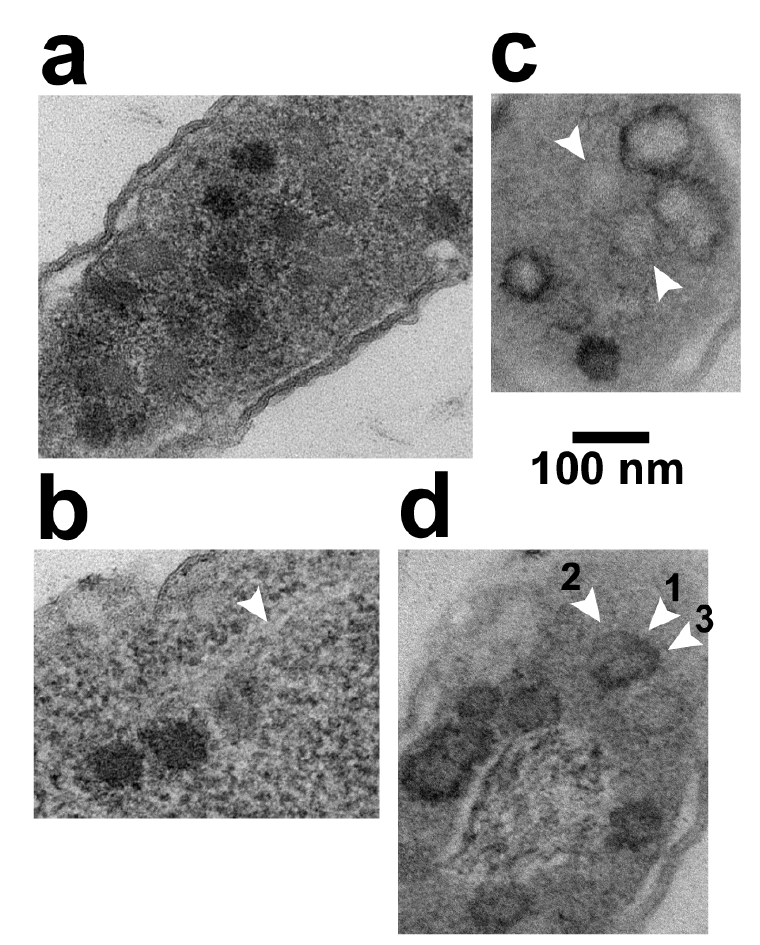
Figure 5. LBP*s and their shells. ( a ), ( b ) LBP*s in cells stained with uranyl acetate / lead; ( c ) as in ( a , b ) with A-PTA staining substituted for staining with lead / uranyl acetate; ( d ) as in ( a ), ( b ) with A-PTA staining after staining with lead / uranyl acetate.